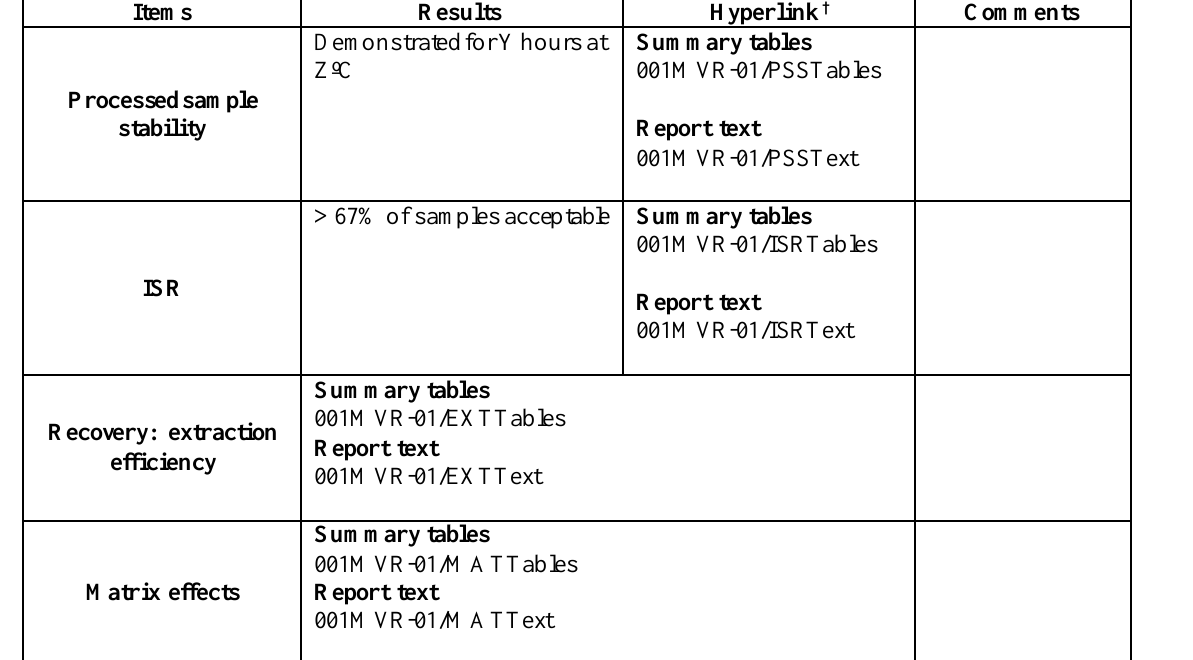
Table 3 continued. Example of an Overall Summary Table for a Method